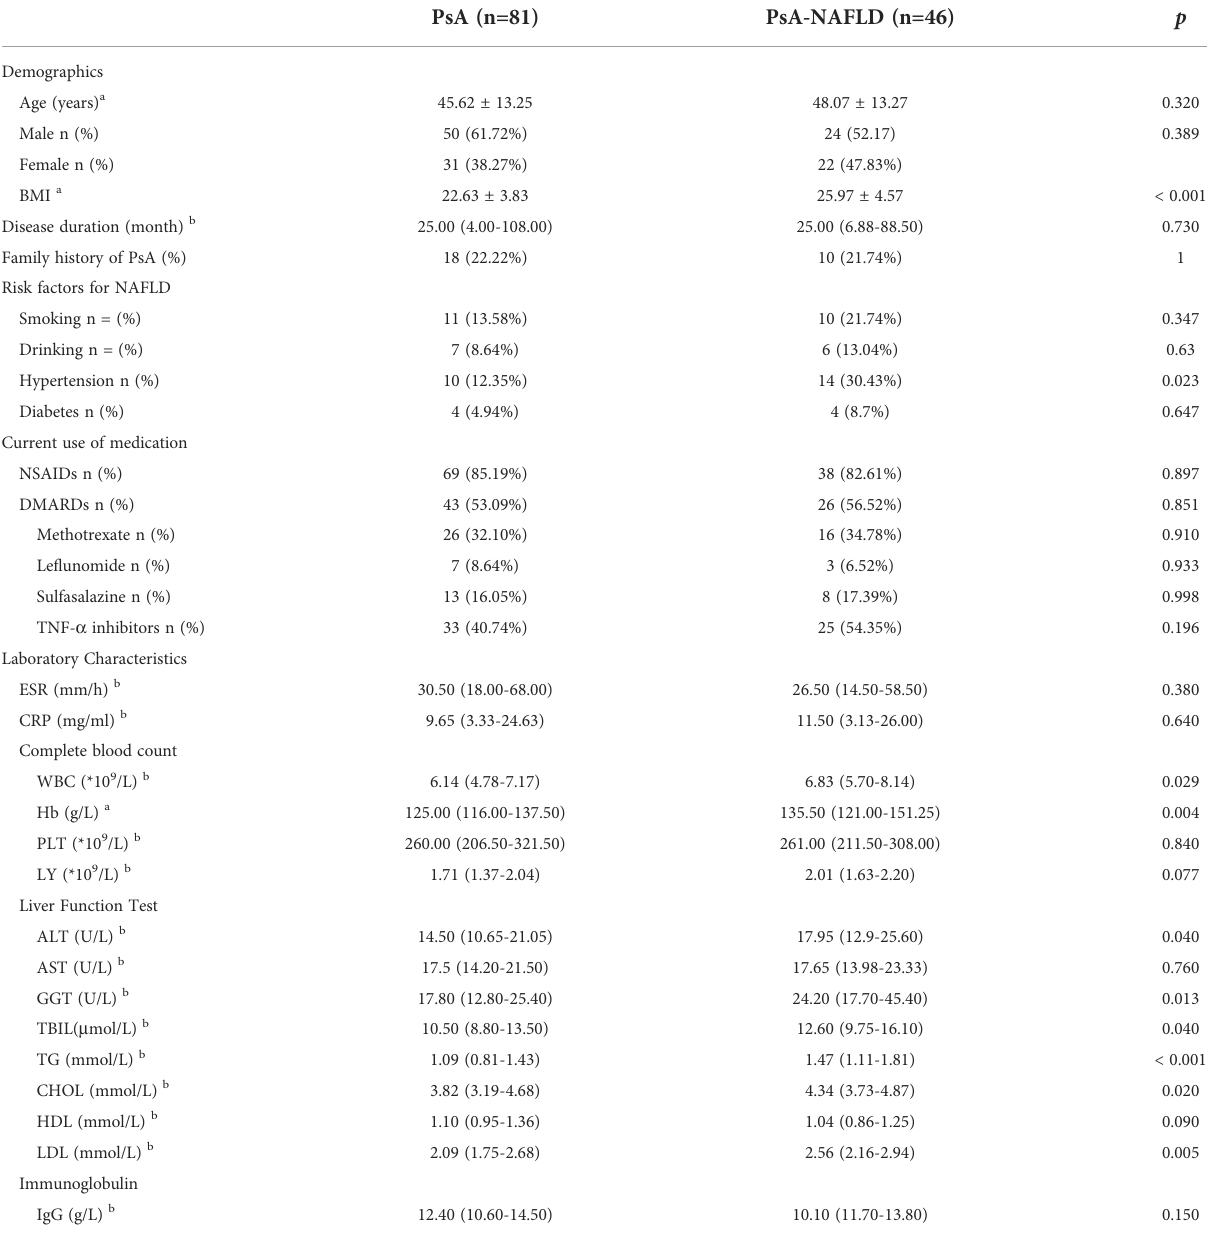
TABLE 1 Clinical characteristics of PsA group and PsA-NAFLD